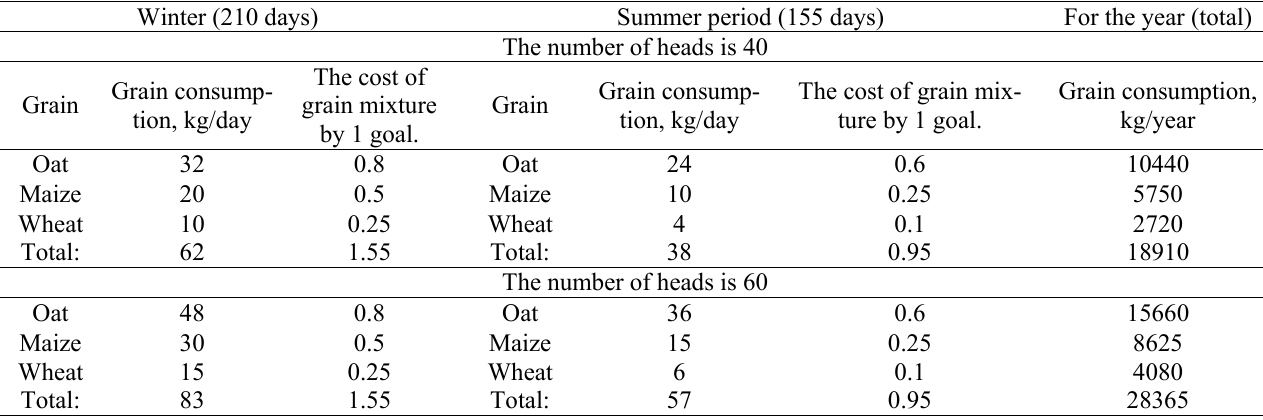
Volumes of grain mix required for feeding deer herds of noble animals in the enclosure of “Polisske-Sarny” Hunting Farm Winter (210 days)